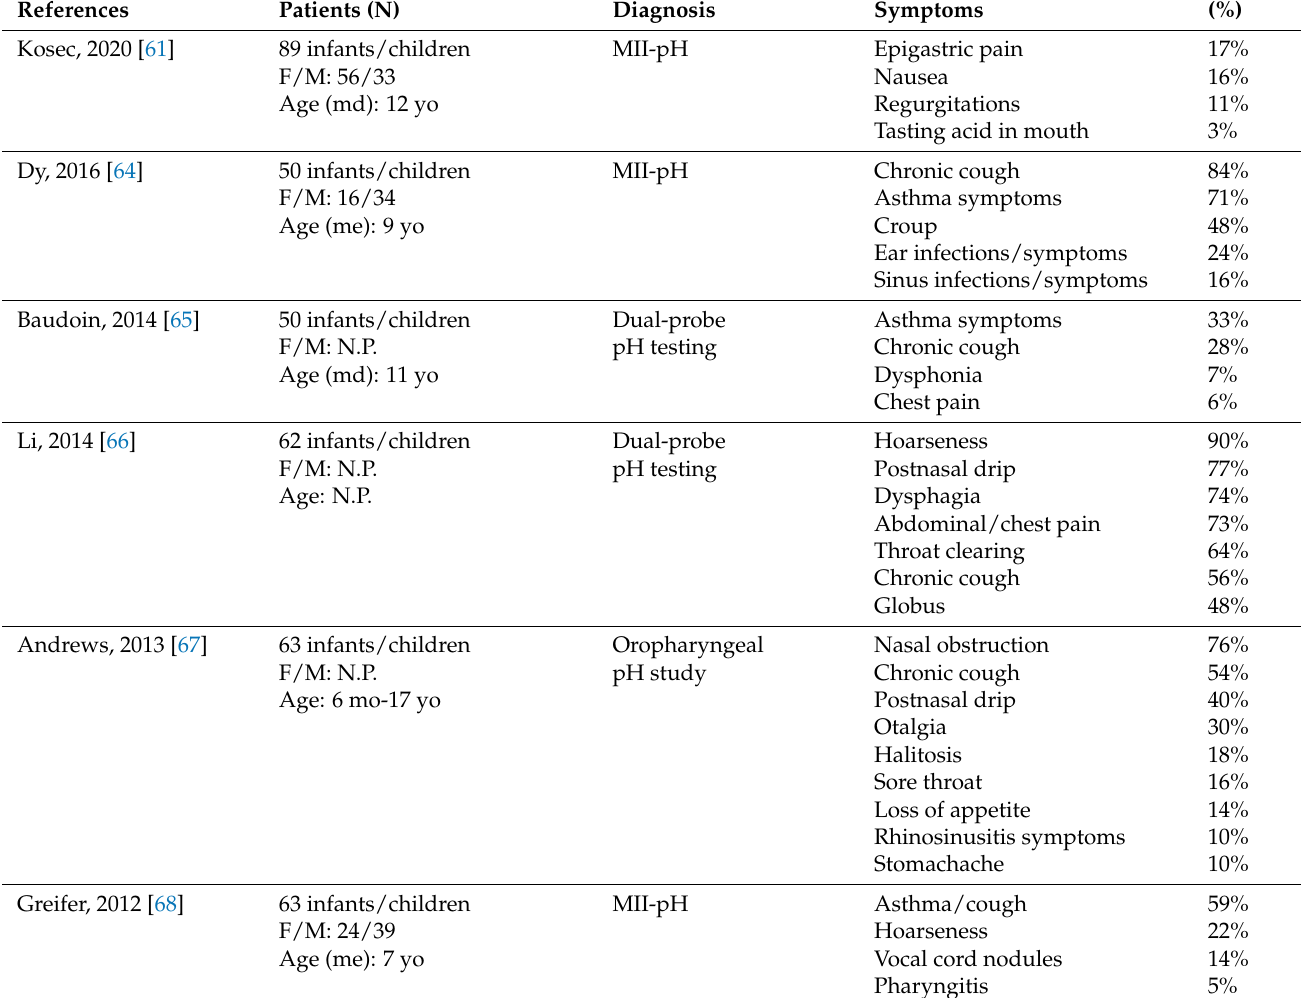
Table 2. Symptoms of Pediatric Laryngopharyngeal